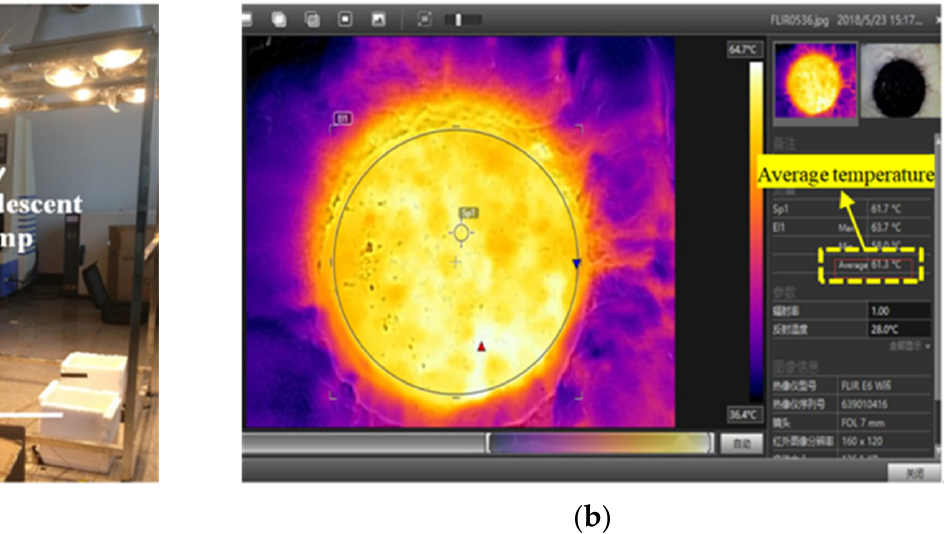
Figure 5. Indoor irradiation test. ( a ) Irradiation test installation; ( b ) Processing of upper surface temperature.